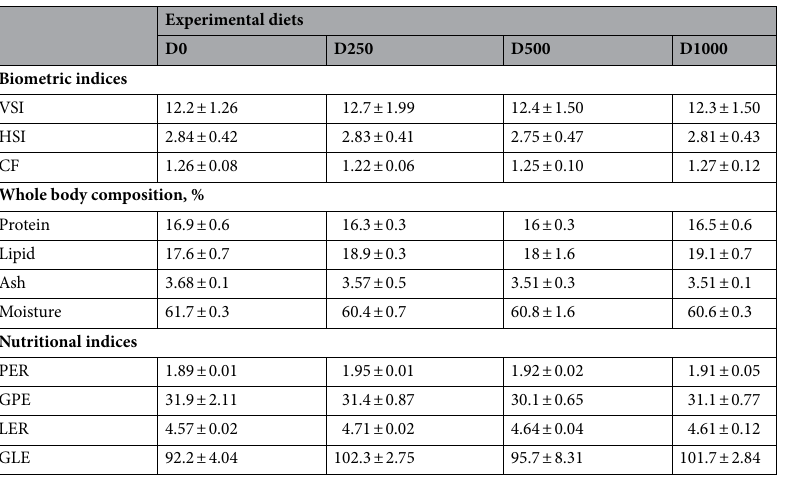
Table 2. Biometric indices, whole body composition and nutritional indices of European sea bass fed the experimental diets D0, D250, D500, D1000 over 71 days. Biometric indices are given as the mean (n = 15) ± SD. No significant differences were detected ( P > 0.05). Whole body composition % are given as the mean (n = 3) ± SD. Nutritional indices are given as the mean (n = 3) ± SD. VSI Viscerosomatic index (%) = 100 × (viscera weight/FBW), HSI Hepatosomatic index (%) = 100 × (liver weight/FBW), CF Condition factor = 100 × (FBW/length 3 ), PER Protein efficiency ratio = (FBW–IBW)/protein intake, GPE (%) Gross protein efficiency = 100 × [(% final body protein × FBW) − (% initial body protein × IBW)]/total protein intake fish, LER Lipid efficiency rate = (FBW − IBW)/lipid intake, GLE (%) Gross lipid efficiency = 100 × [(% final body lipid × FBW) − (% initial body lipid × IBW)]/total lipid intake